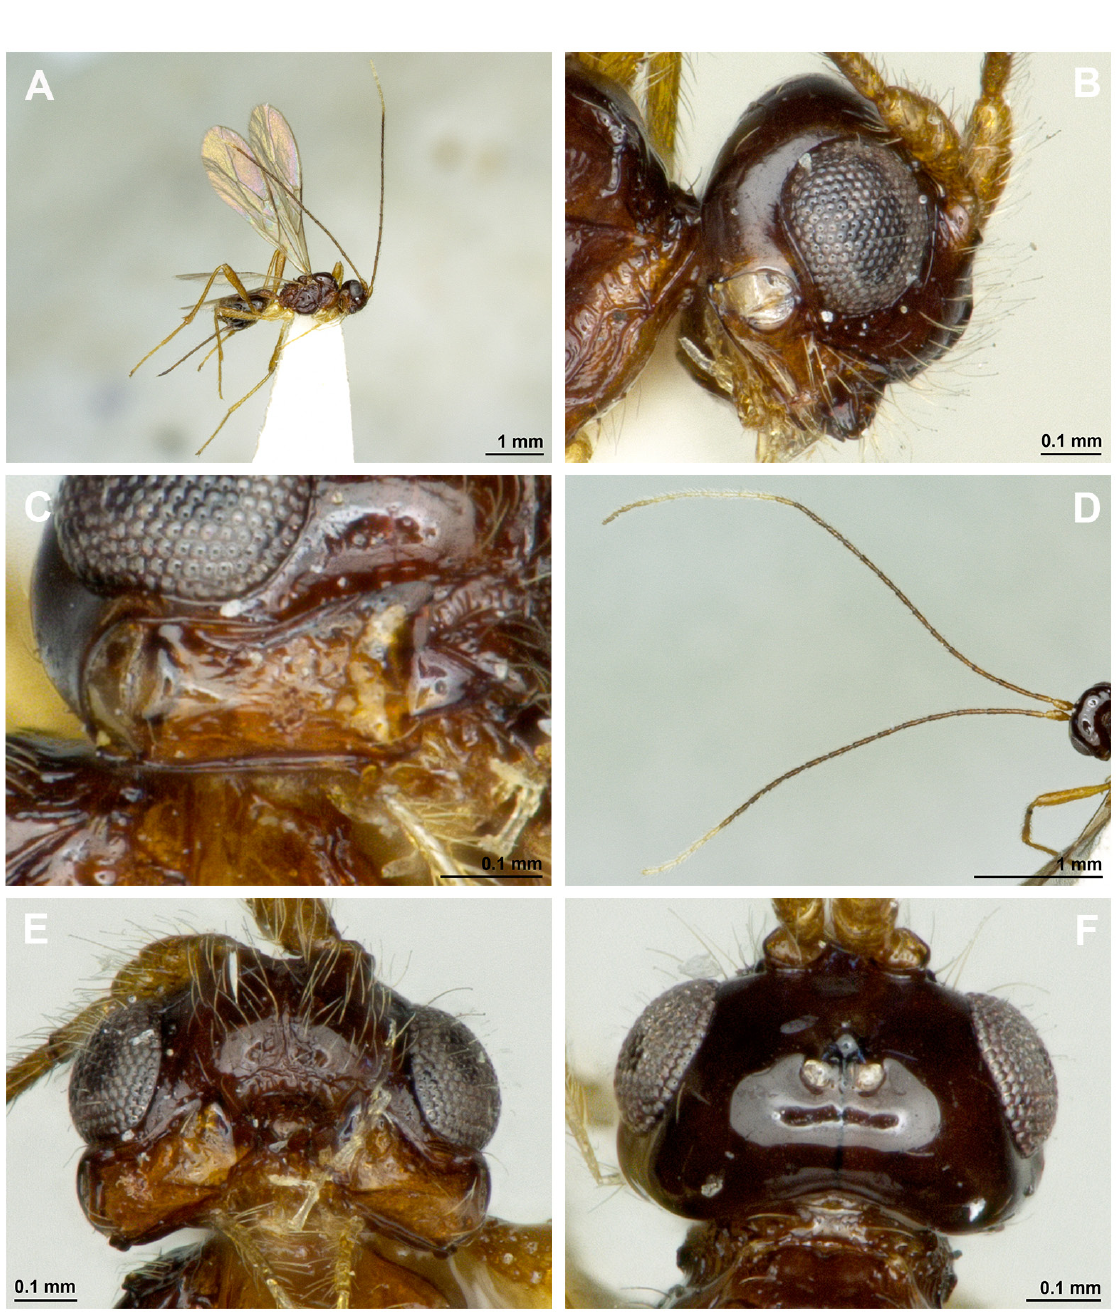
Fig. 58. Asobara stubbsi Peris-Felipo, sp. nov., ♀, holotype (BMNH 1972-211). A . Habitus, lateral view. B . Head, lateral view. C . Antenna. D . Mandible. E . Head, front view. F . Head, dorsal